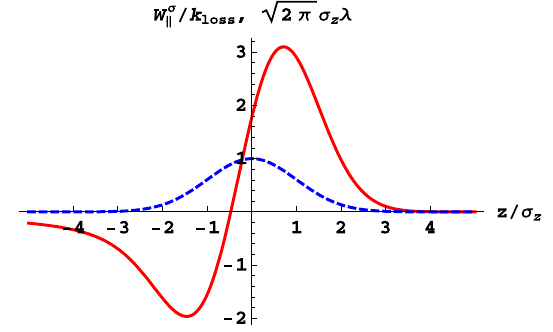
FIG. 1. (Color) Longitudinal wake potential (solid) and beam density (dashed); head of the bunch is z > 0 ; k loss > 0 is given by Eq.